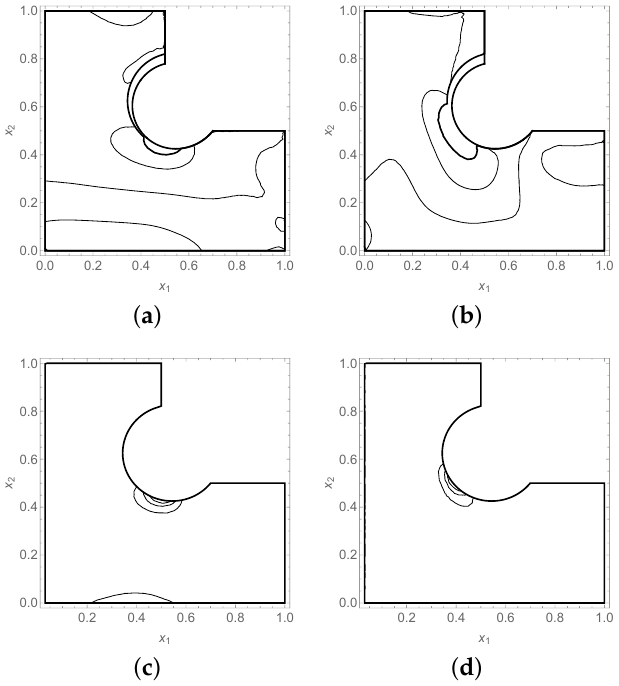
Figure 7. Stress field. Contour plots of the expectation and variance of σ 11 and σ 22 . ( a ) Expected value of σ 11 ; ( b ) Expected value of σ 22 ; ( c ) Variance of σ 11 ; ( d ) Variance of σ 22